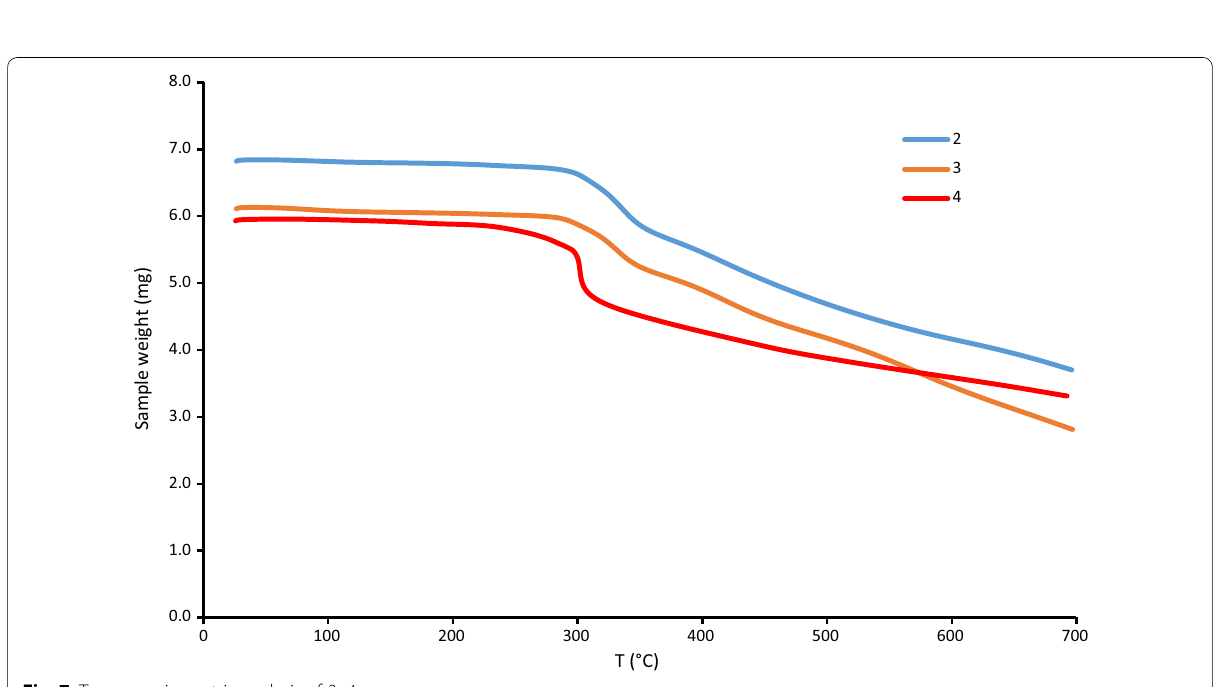
Fig. 7 Termogravimmetric analysis of 2 –